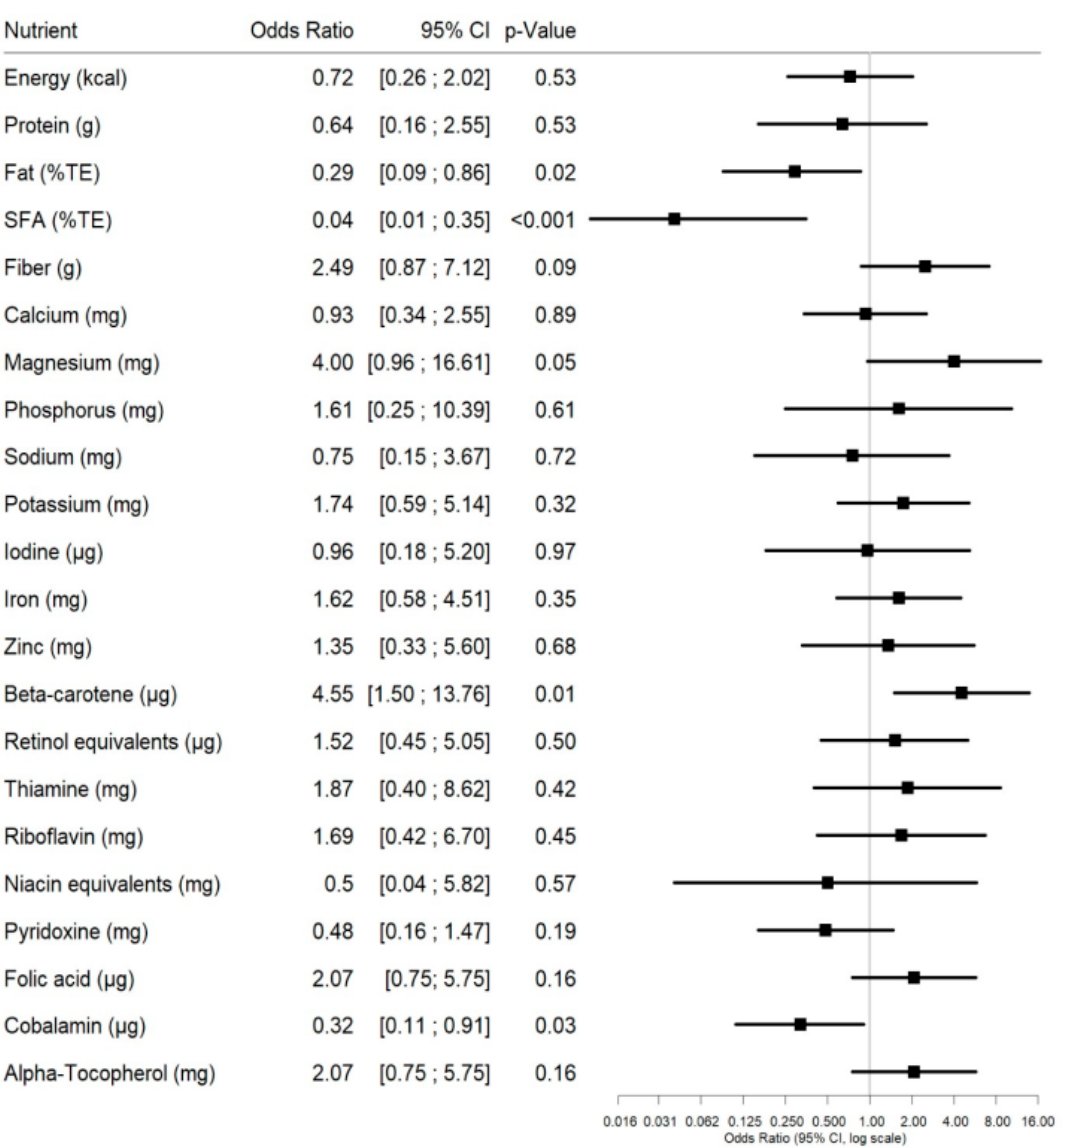
Figure 1. Forest plots showing odds ratios, 95% confidence intervals, and p -values (resulting from chi-squared tests) for selected nutrients. OR indicate the chance of vegetarians exceeding the dietary reference values (DRV) compared to omnivores.